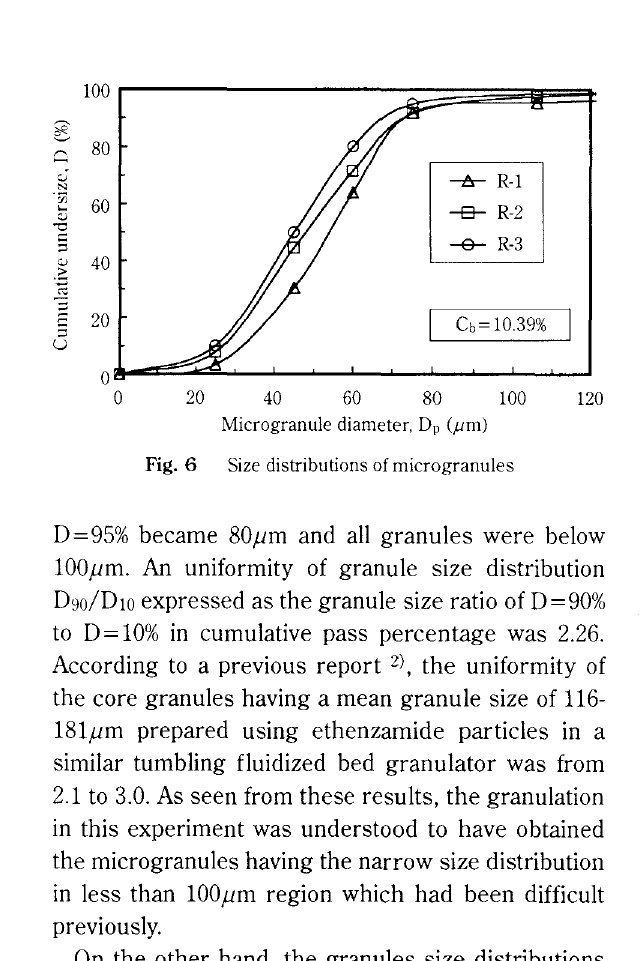
Fig. 6 Size distributions of micro granules